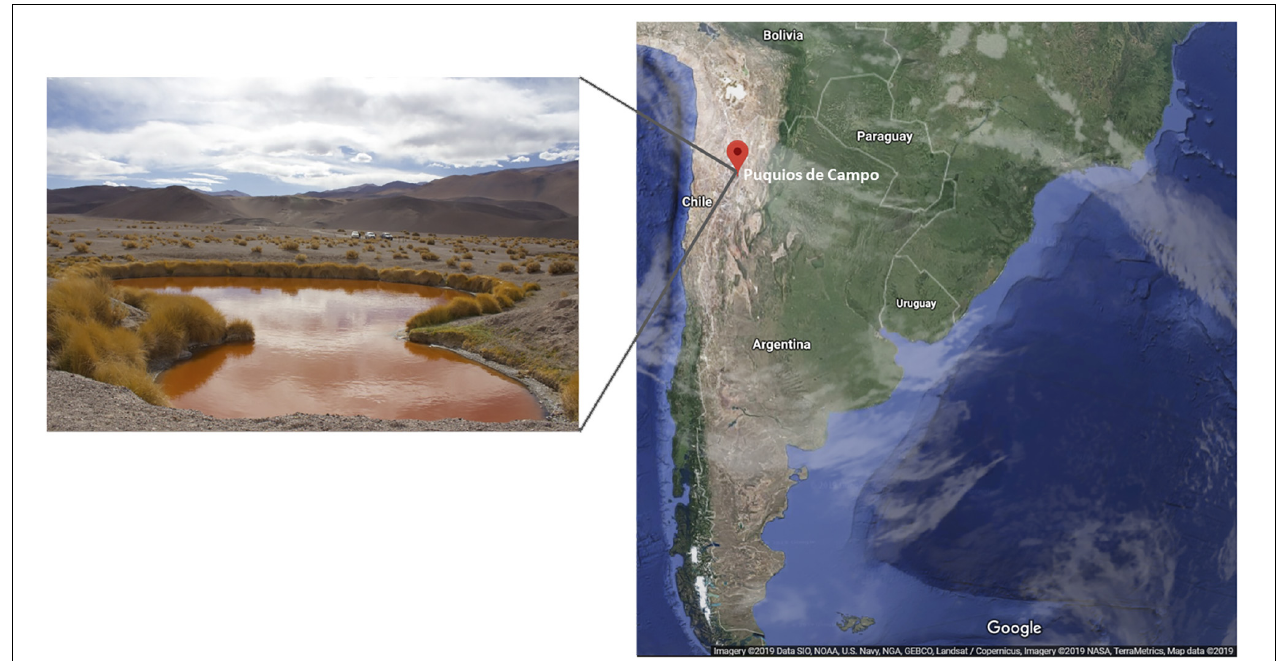
FIGURE 1 | Puquio de Campo Naranja lake, located in Catamarca province,